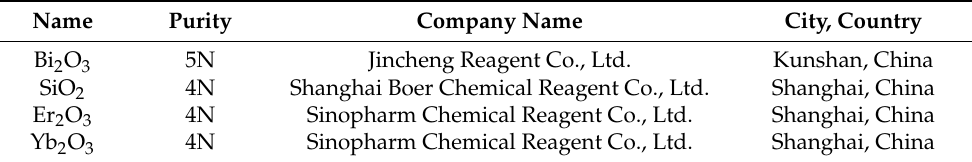
Table 1. Experimental drugs used to grow pure BSO, Er: BSO, and Er/Yb: BSO crystals.